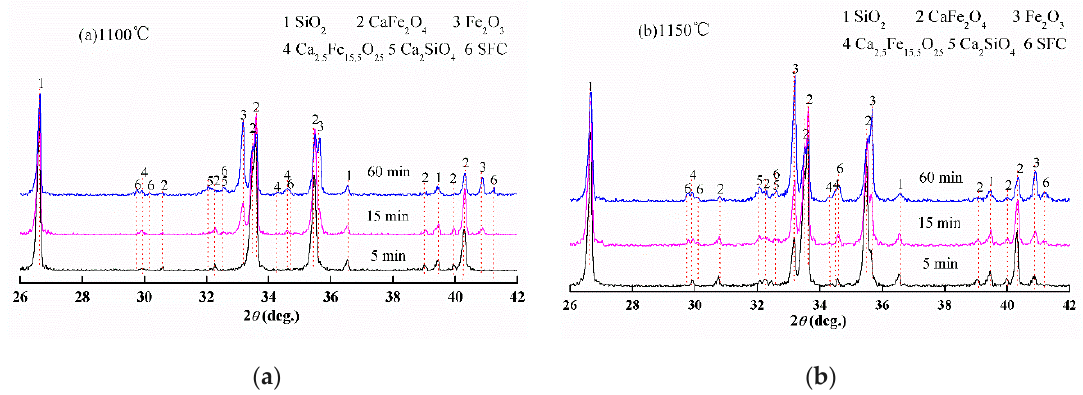
Figure 1. XRD patterns of the reaction products between SiO 2 and CF sintered at 1100 °C ( a ) and 1150 °C ( b ) for 5 min, 15 min and 60 min respectively.